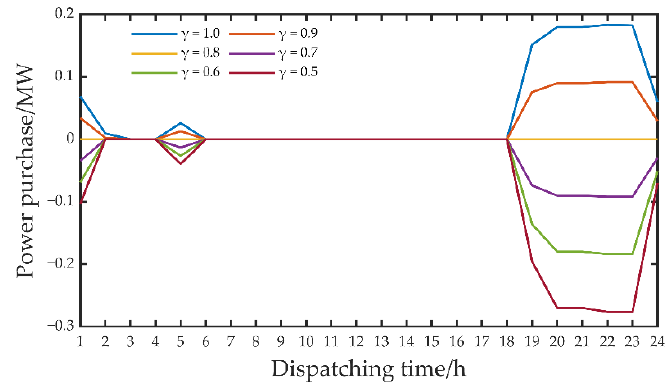
Figure 18. Power purchase under different mass flow rates.